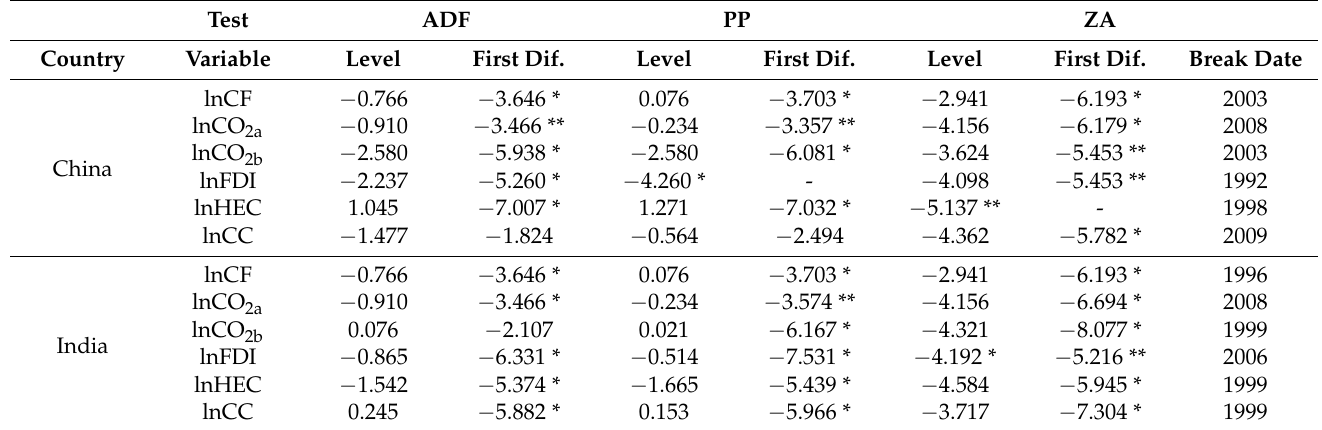
Table 4. Unit root test